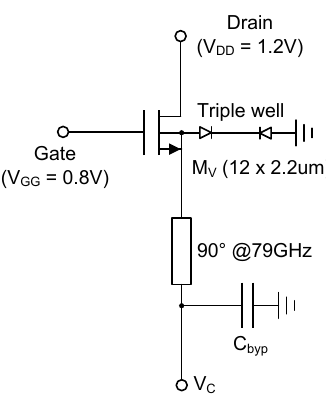
Figure 7. Schematic of the MOS − varactor used in the W-band amplifier.